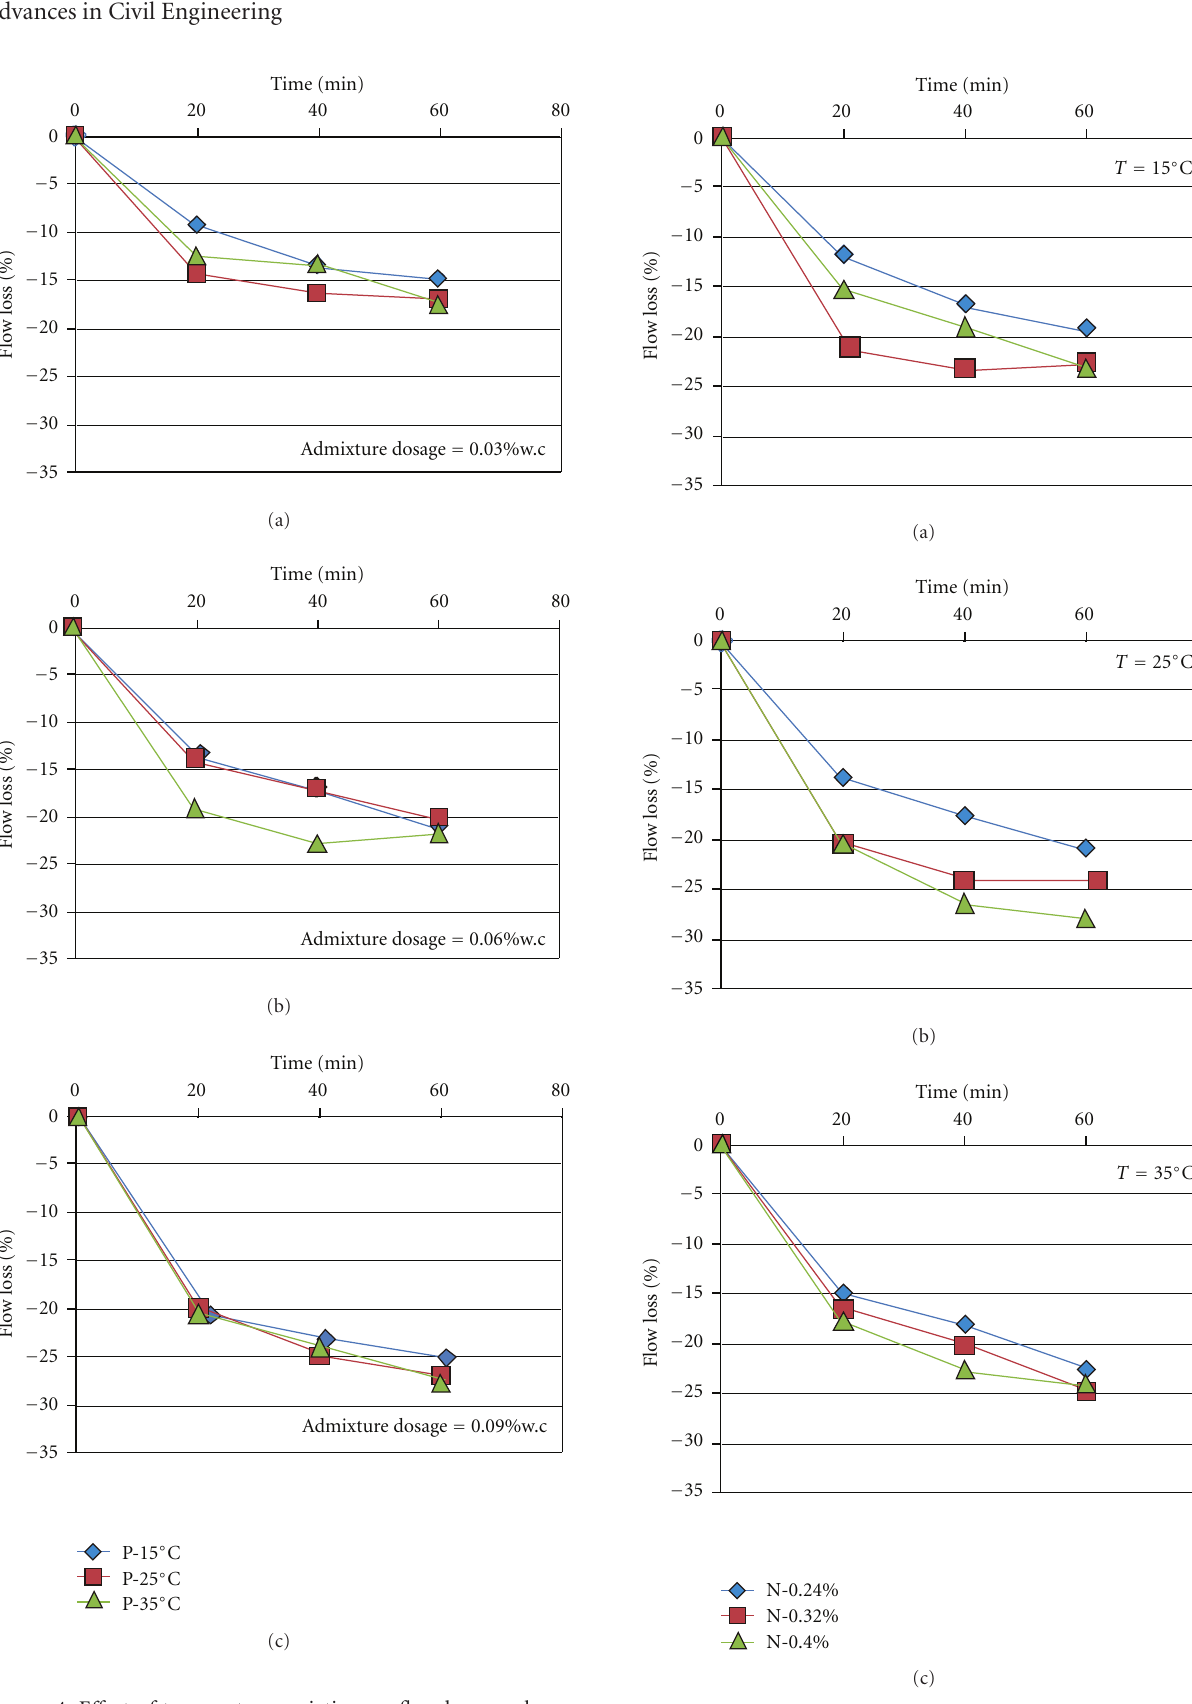
Figure 4: E ff ect of temperature variation on flow loss—poly-car- boxylate. Figure 5: E ff ect of admixture dosage on flow